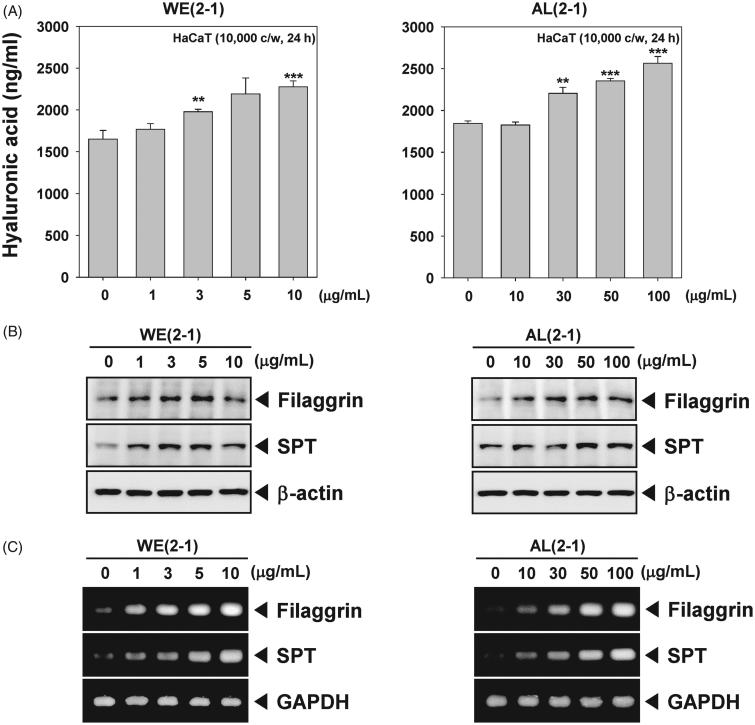
WE(2-1) and AL(2-1) stimulates filaggrin and serine palmitoyltransferase (SPT). (A) HaCaT cells (1 × 106 cells/well) were exposed to indicated concentrations of WE(2-1) and AL(2-1) for 24 h, and then supernatant collected for investigation using a Hyaluronic acid assay kit following the manufacturer’s instructions. (B) HaCaT cells (1 × 106 cells/well) were treated with the indicated concentrations of WE(2-1) and AL(2-1) for 24 h. Total RNA was isolated, and filaggrin and SPT mRNA expressions were examined by RT-PCR analysis. PCR of glyceraldehydes-3-phosphatedehydrogenase, GAPDH, was performed to control for a similar initial cDNA content of the sample. The results shown are representative of the three independent experiments. (C) HaCaT cells (1 × 106 cells/well) were treated with indicated concentrations of WE(2-1) and AL(2-1) for 24 h and then analyzed by Western blot analysis using antibodies against filaggrin, and SPT. β-actin was used as a loading control. The blots shown are representative of three independent experiments that had similar results.